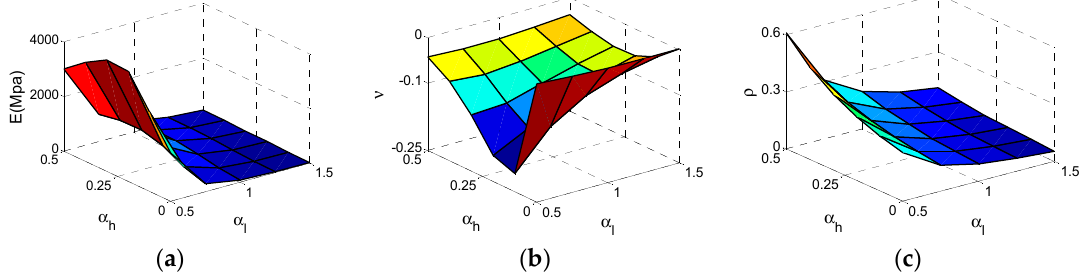
Figure 8. The Surfaces of effective properties for Type B cell: ( a ) effective Young’s modulus E ; ( b ) effective Poisson ratio v ; ( c ) relative density ρ .